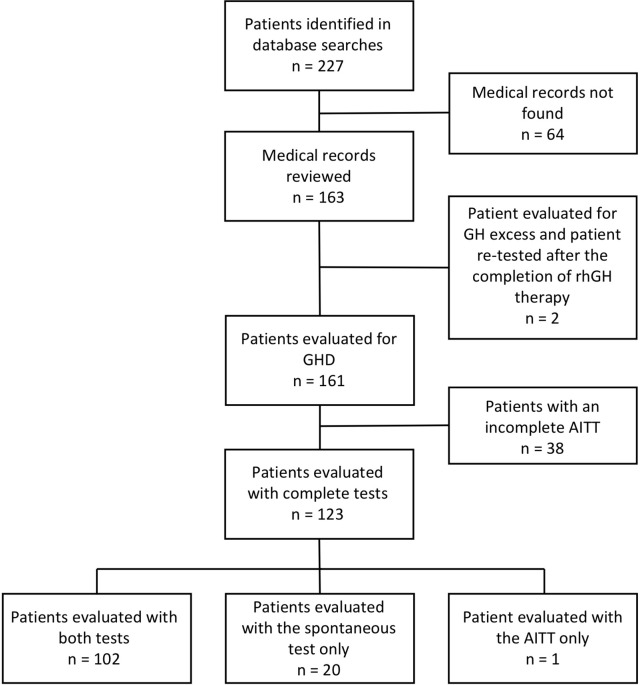
Flowchart of included and excluded children with short stature evaluated for possible GHD. AITT, arginine-insulin tolerance test. GH, growth hormone. GHD, growth hormone deficiency.